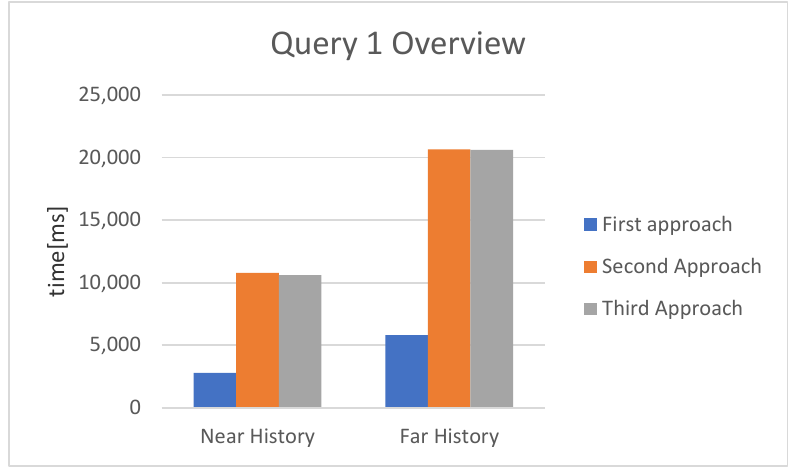
Figure 9. Results for Query 1.